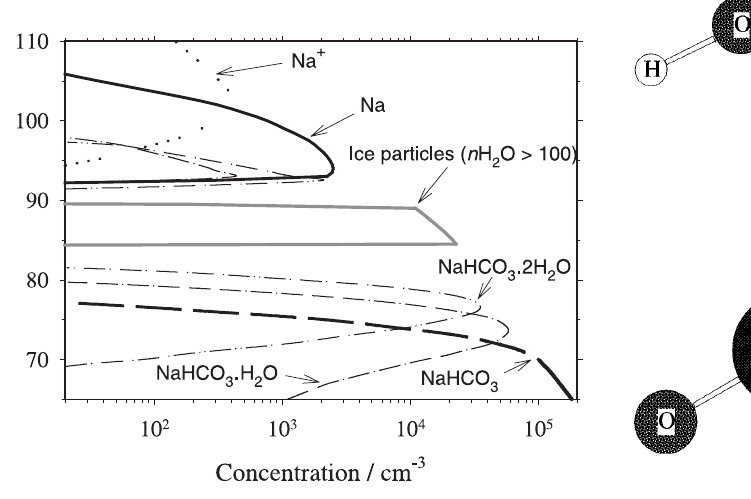
Fig. 6. Profiles of Na, Na + , NaHCO ( n = 1, 2 and >100), predicted by the 1D sodium model for early July at 70 (cid:176) N